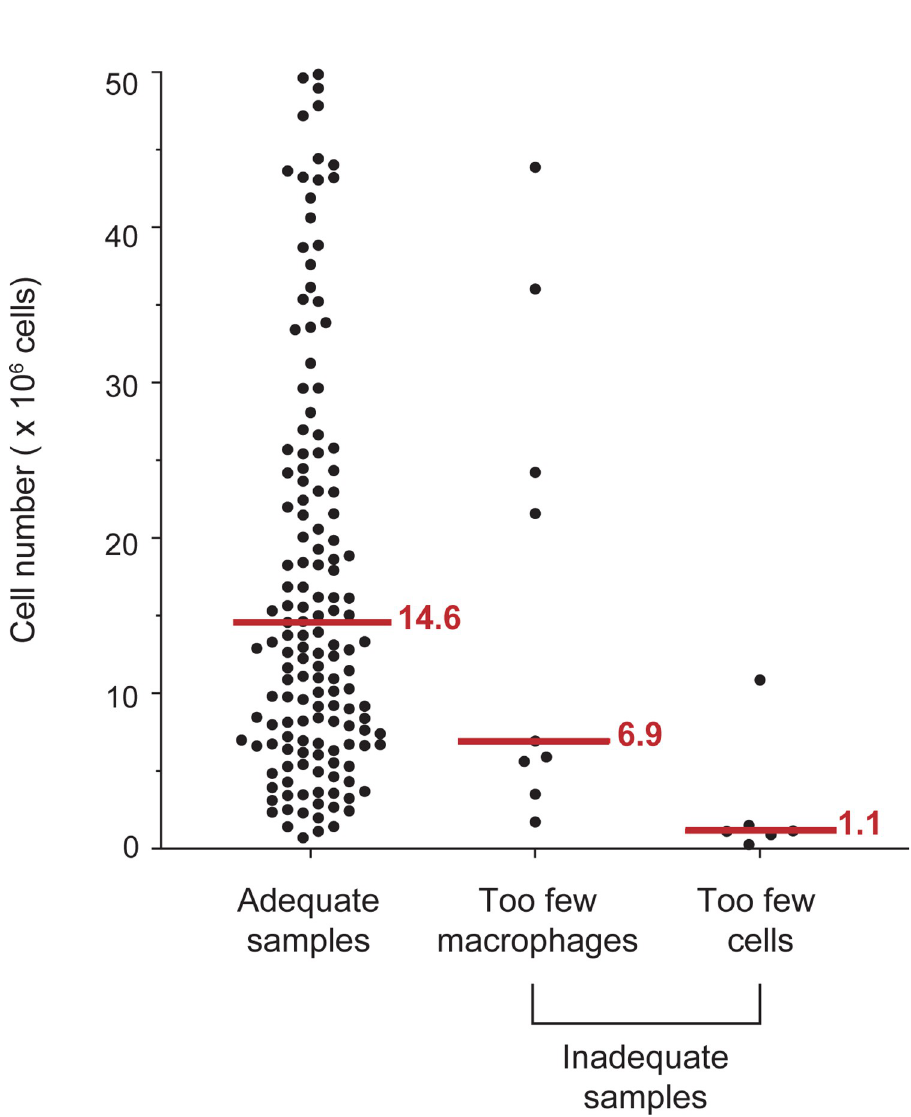
Fig 4. Sample adequacy and criteria for sample exclusion. Shown are the total number of sputum cells (excluding SECs) of individual samples prior to antibody labeling. All adequate samples (n = 164) revealed > 0.05% macrophages (alveolar and interstitial combined). Not depicted are 18 adequate samples, whose sputum cell count exceeded 50 million cells. The inadequate samples (n = 15) either showed no alveolar macrophages or the combined events in the alveolar and interstitial macrophage gates were < 0.05%. A subset of the inadequate samples contained “too few cells” for a reliable profile ( < 1000 CD45 + events), while the remainder included enough cells, though did not fulfill the QC macrophage criteria to consider them adequate samples. The red lines and numbers indicate the median cell count for each sample group.